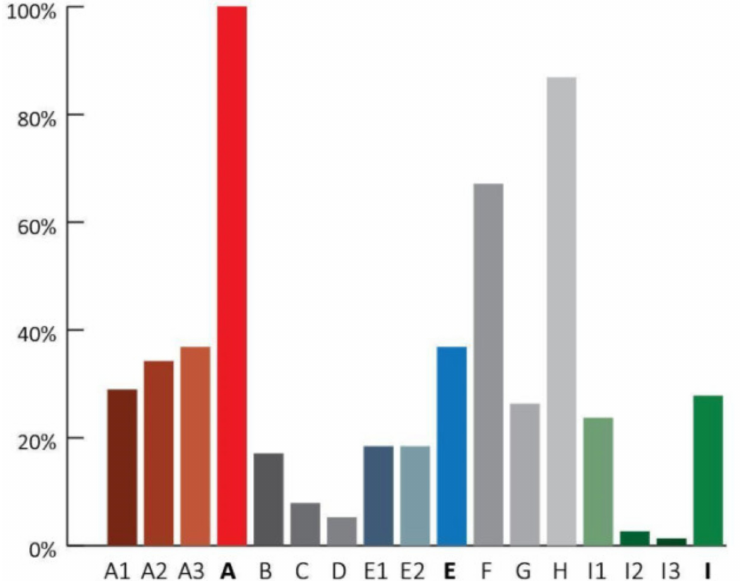
Figure 1. Incidence of the anti-COVID measures implementation in the total number of examined facilities. Own